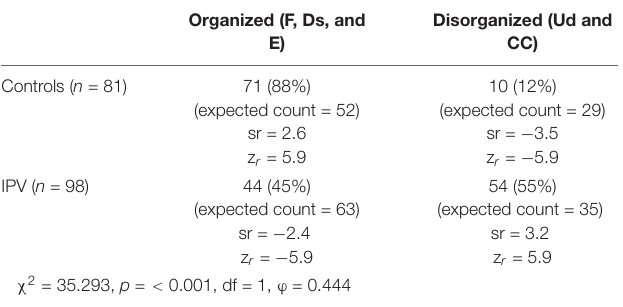
TABLE 4 | AAI classifications (organized vs. disorganized) in the IPV and control group.